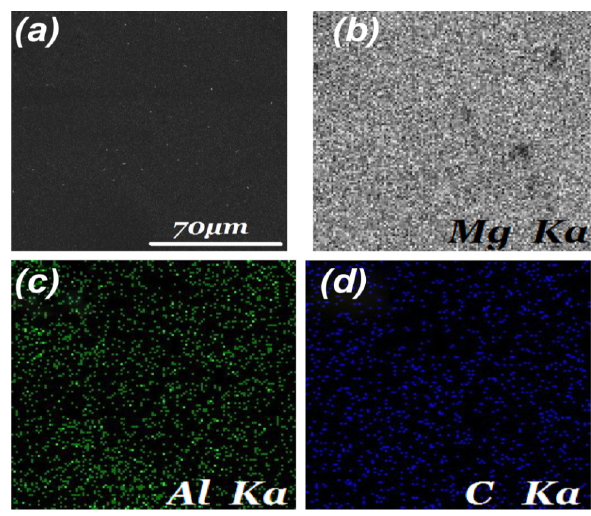
Figure 8. X ‐ ray maps of: ( a ) Mg ‐ 1.0 wt. % Al ‐ 0.018 wt. % GNP composite; ( b ) Mg; ( c ) Al; ( d ) carbon, Figure 8. X-ray maps of: ( a ) Mg-1.0 wt. % Al-0.018 wt. % GNP composite; ( b ) Mg; ( c ) Al; ( d ) carbon, reproduced from [95], with permission from Elsevier, 2018. reproduced from [95], with permission from Elsevier,